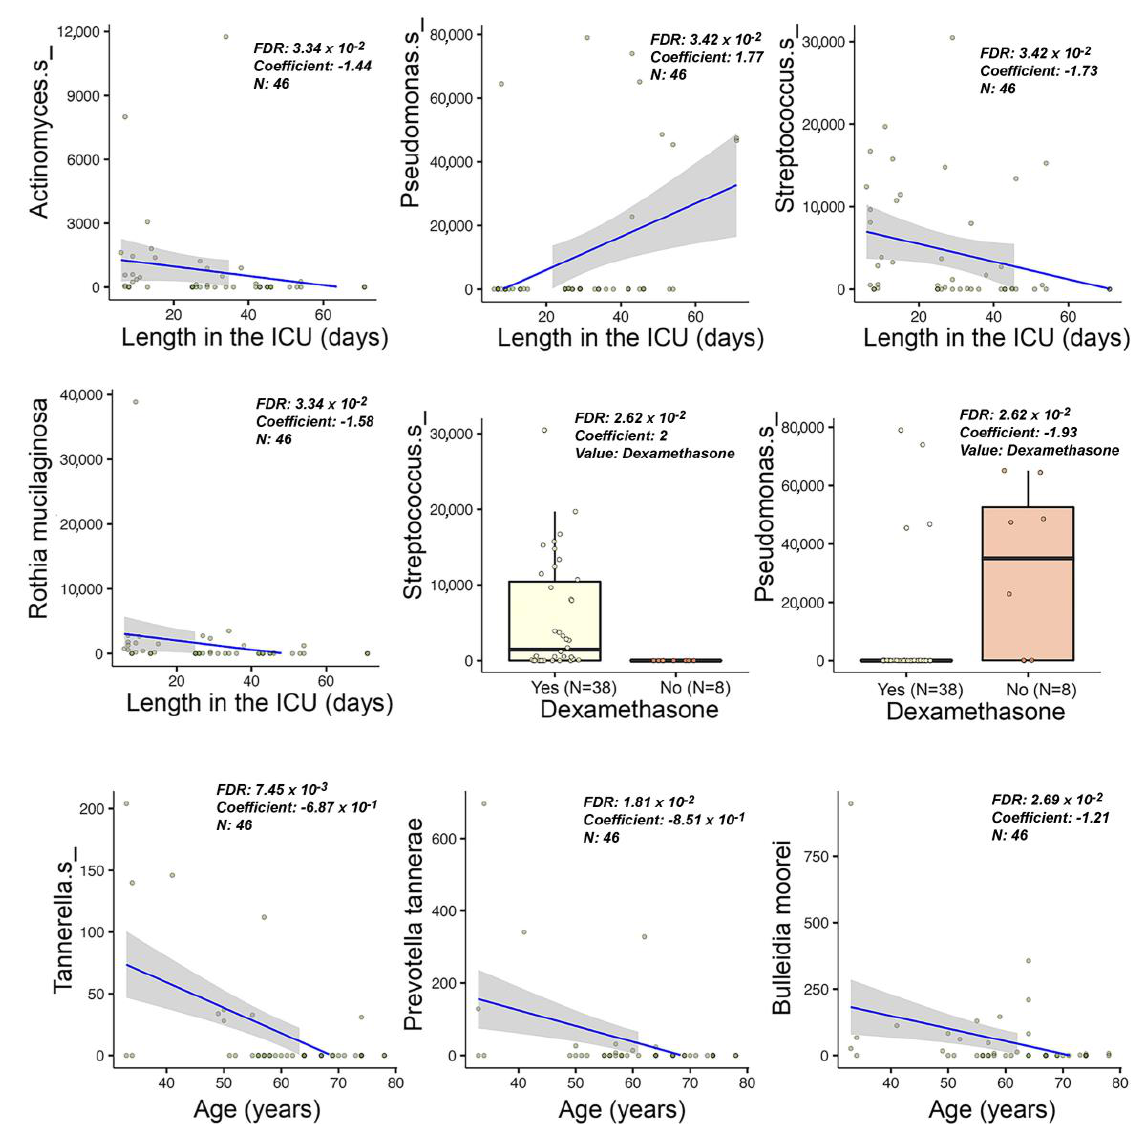
Figure 6. Association between clinical/laboratory data and microbiome composition data of the tracheal aspirate at baseline for ICU-COV(+) patients using MaAsLin2. Only the most significant results are shown (FDR < 0.05 are specified for each association). Respiratory microbiome data are plotted in raw counts.